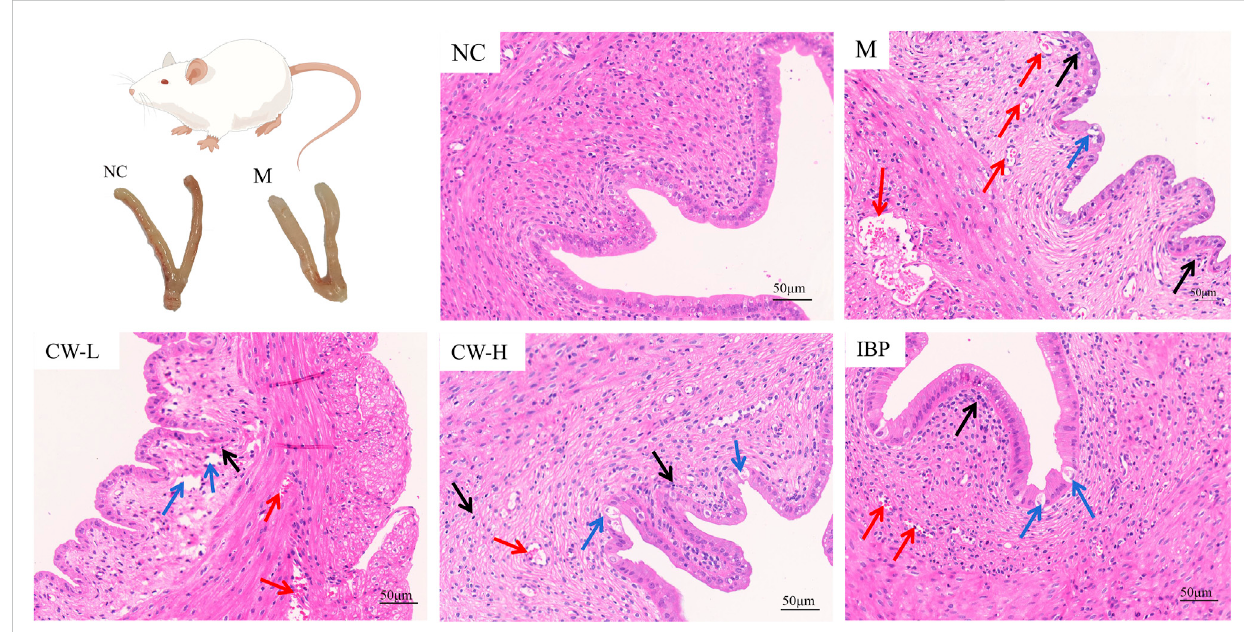
FIGURE 2 H&E staining of rat uterus tissue (20 × 20). Vacuolated epithelial cells ↑ , in fl ammatory cells ↑ , and congested cells ↑ . NC, Normal control group; M, Model group; CW-L, CW low-dose group; CW-H, CW high-dose group; IBP, Ibuprofen positive control